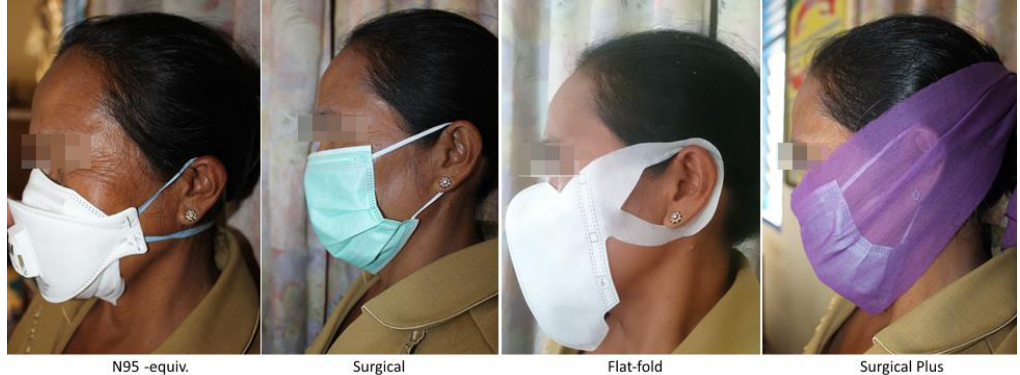
Figure 1. Selected masks for testing in the wearability study.